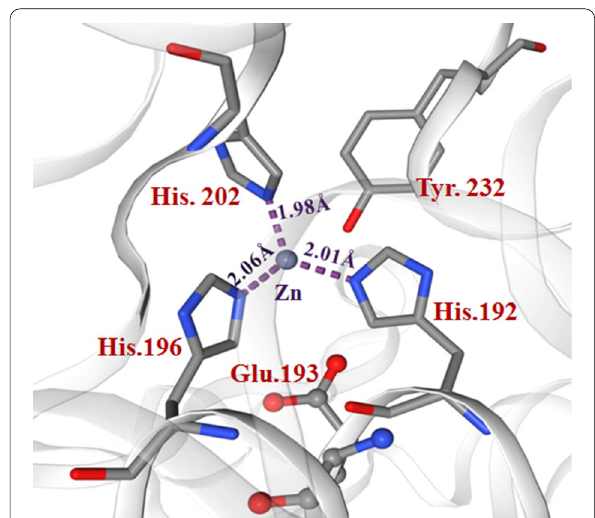
Fig. 9 Stereoview of the zinc-binding site in the Serratiopeptidase. The zinc ion is shown as a purple ball. The active site